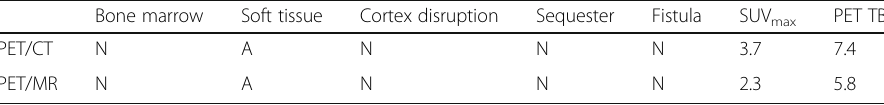
Table 5 Consensus results for patient